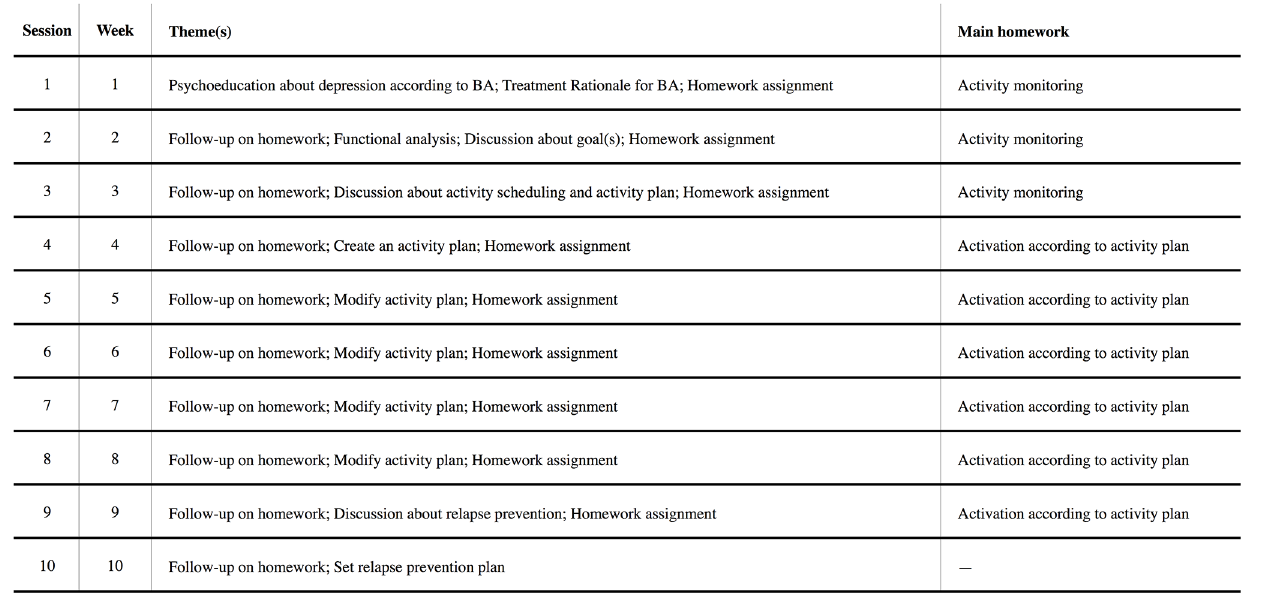
Fig 3. Description of session content for full BA